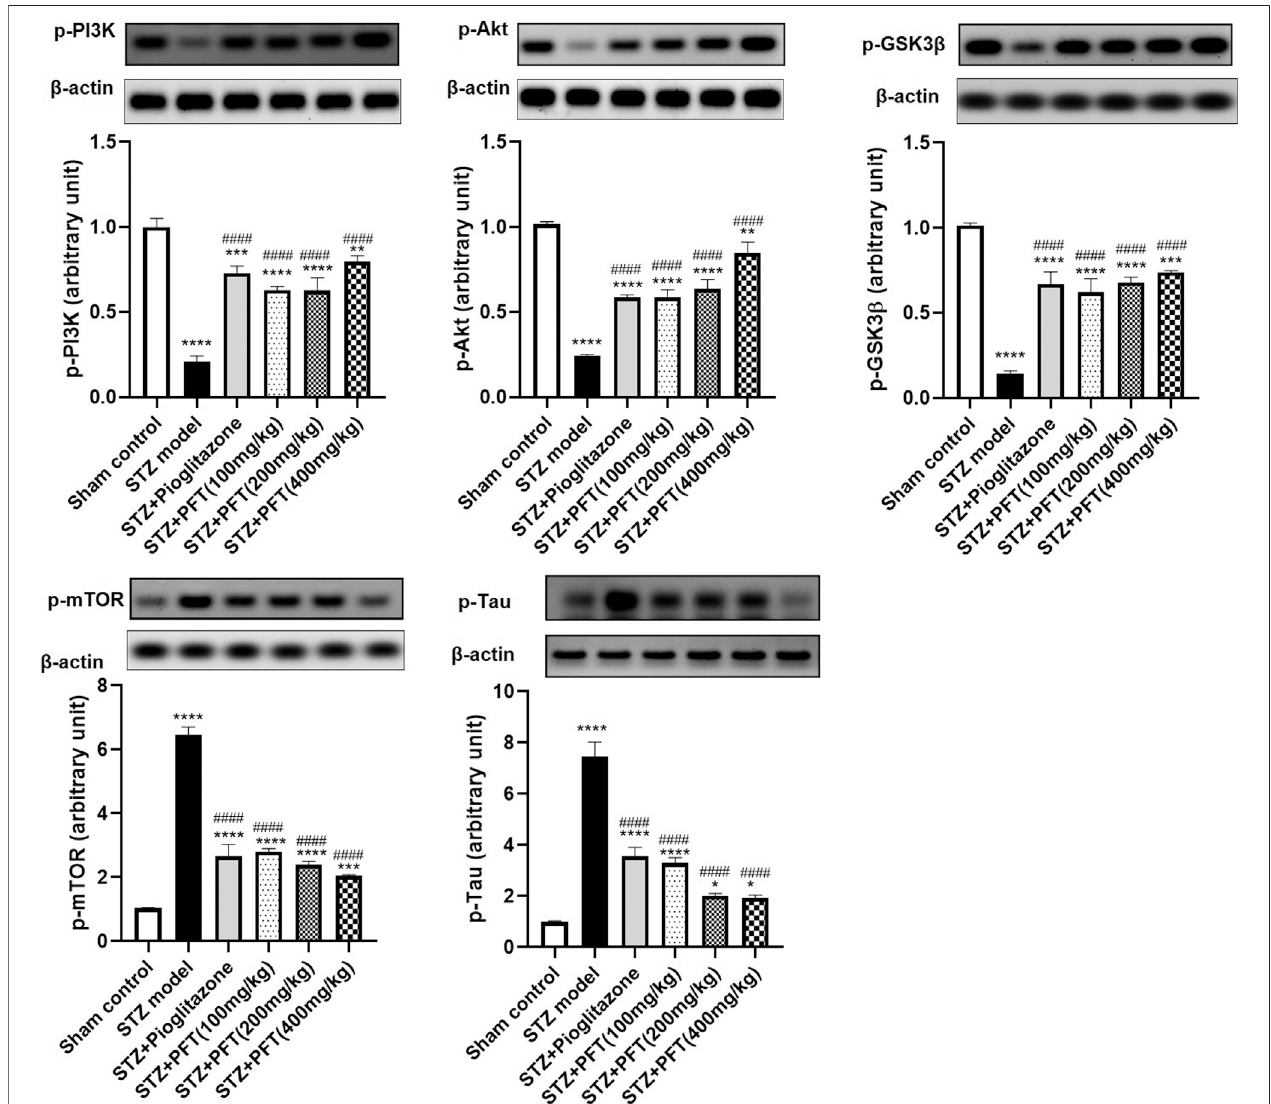
FIGURE 4 | PFT ameliorated STZ-induced discrepancies in p-PI3K, p-Akt, p-GSK-3 β , p-mTOR, and p-tau expression in the hippocampus. Each bar with vertical linerepresentsthemean ± SDofthreemicepergroup;*signi fi cantlydifferentfromtheshamcontrolgroupat p < 0.05, ** signi fi cantlydifferentfromtheshamcontrolgroup at p < 0.01, *** signi fi cantlydifferentfromtheshamcontrolgroupat p < 0.001, **** signi fi cantlydifferentfromtheshamcontrolgroupat p < 0.0001, #### signi fi cantlydifferent from the STZ group at p < 0.0001 using One-Way ANOVA followed by Tukey ’ s multiple comparisons test.